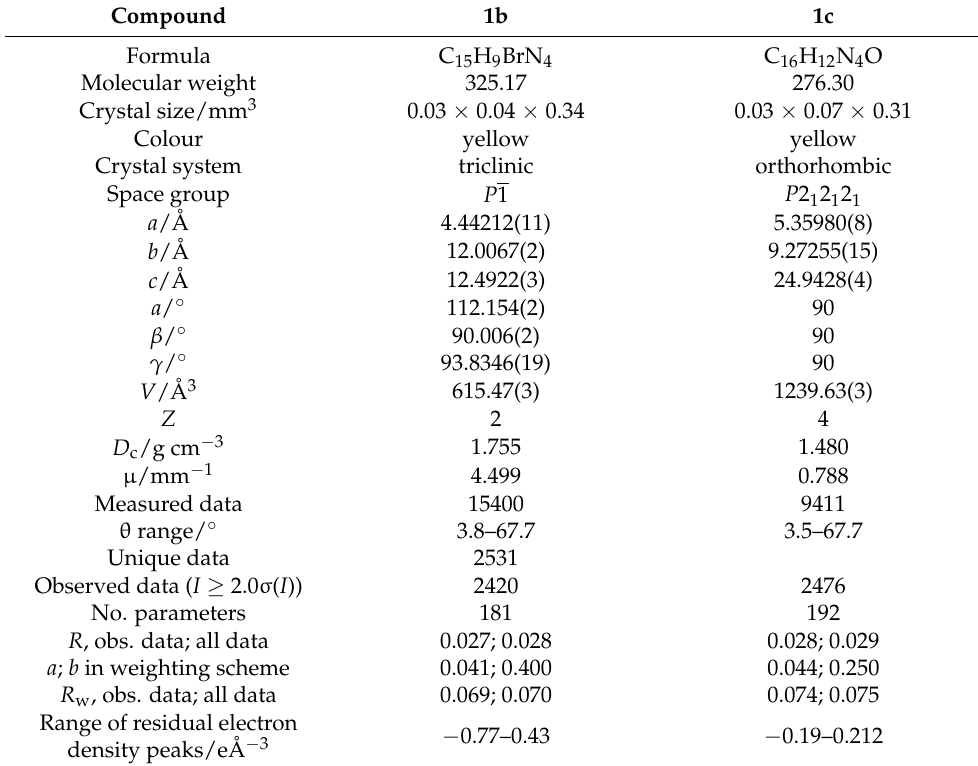
Table 1. Crystallographic data and refinement details for 1b and 1c